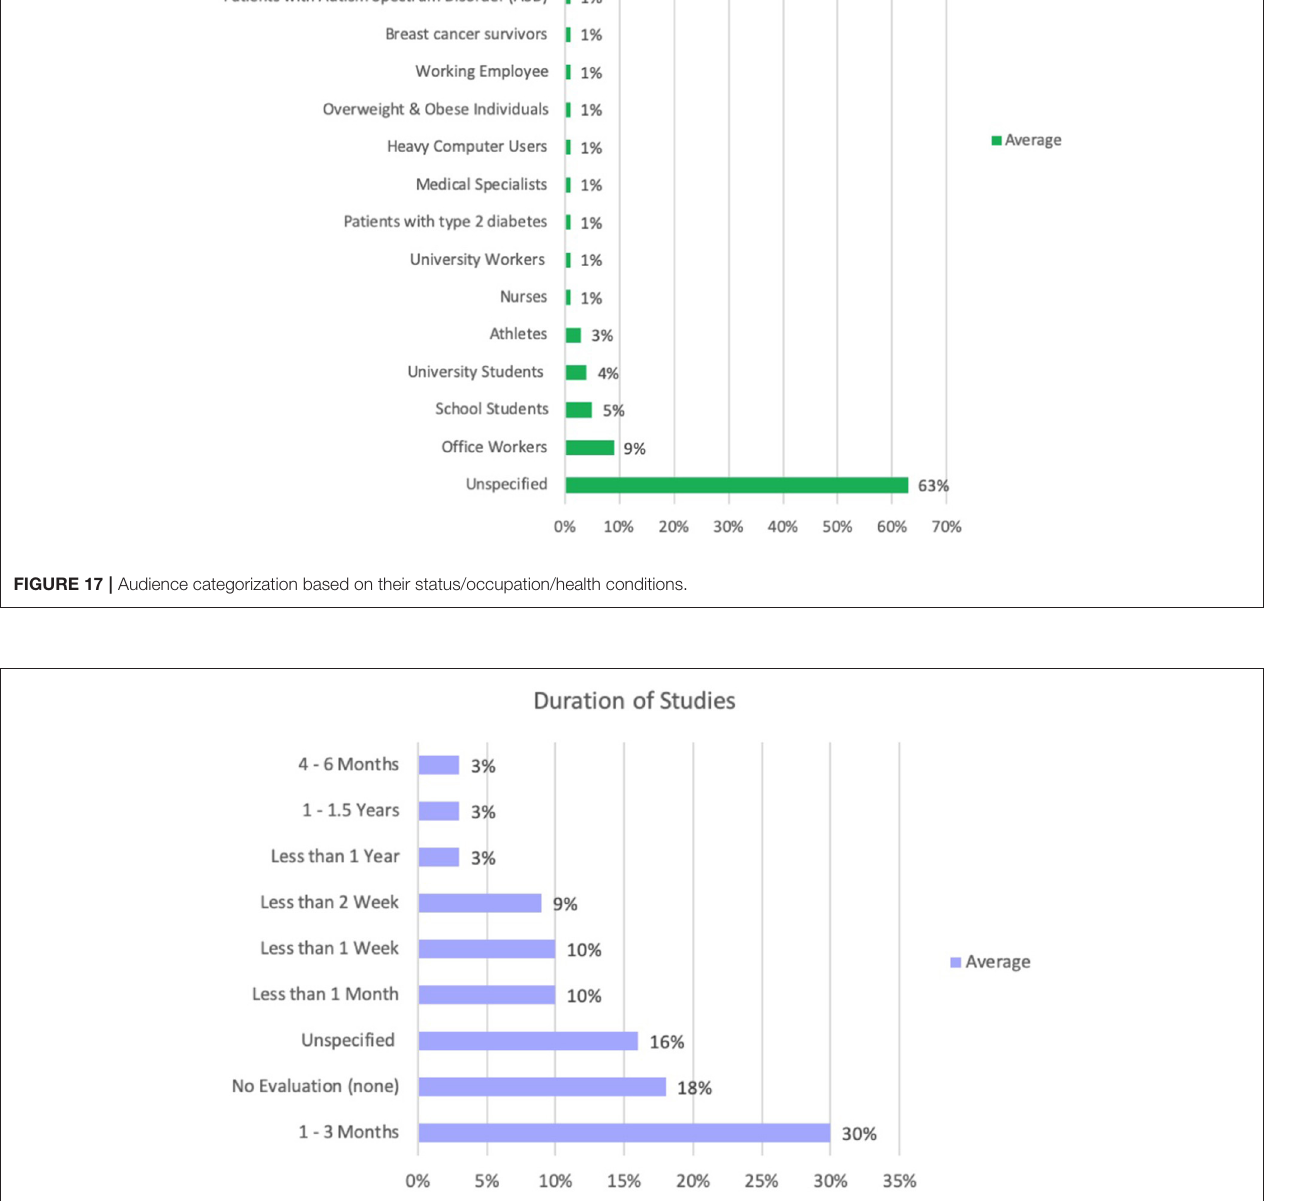
FIGURE 18 | Duration of studies’